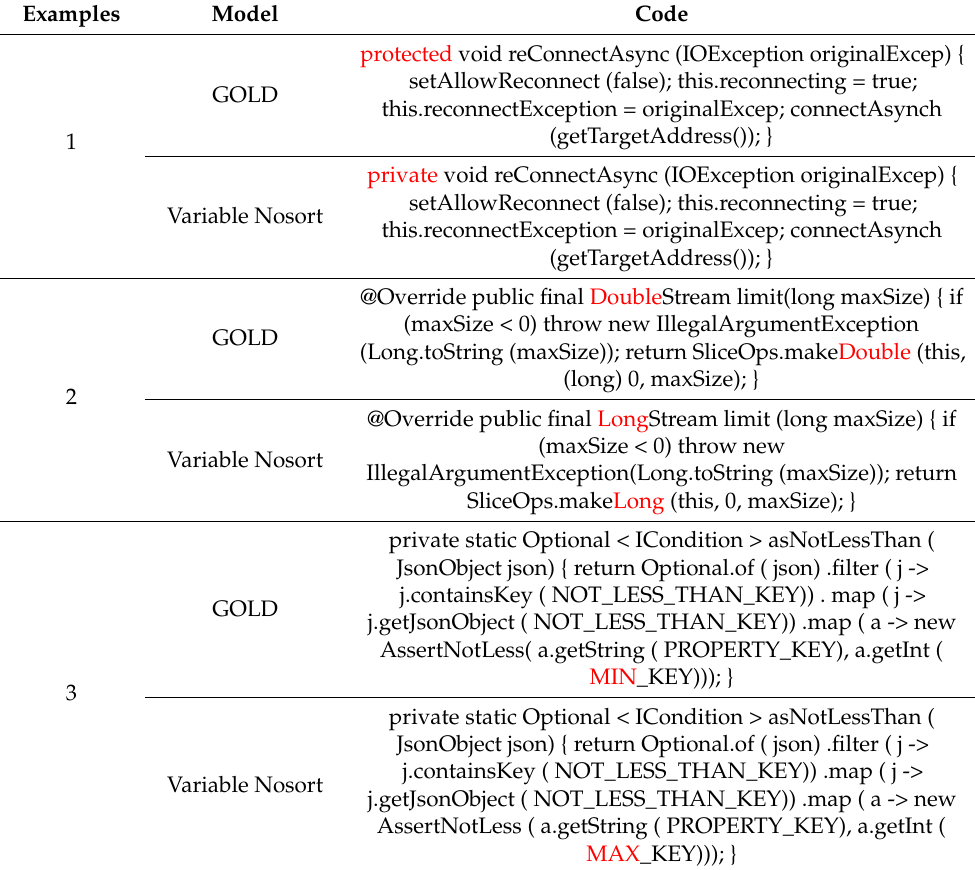
Table 9. Examples of code generation with code graph.